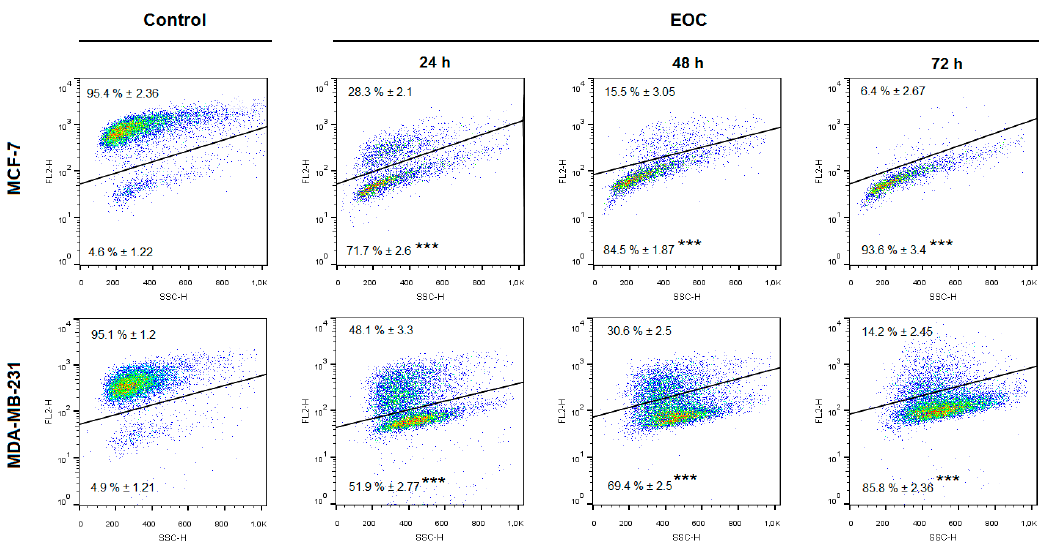
Figure 13. Effect of EOC treatment on mitochondrial membrane potential (MMP) changes in MCF-7 and MDA-MB-231 cells. Data were obtained from three independent experiments and significant differences were marked as p < 0.001 (***) vs. control cells (untreated).